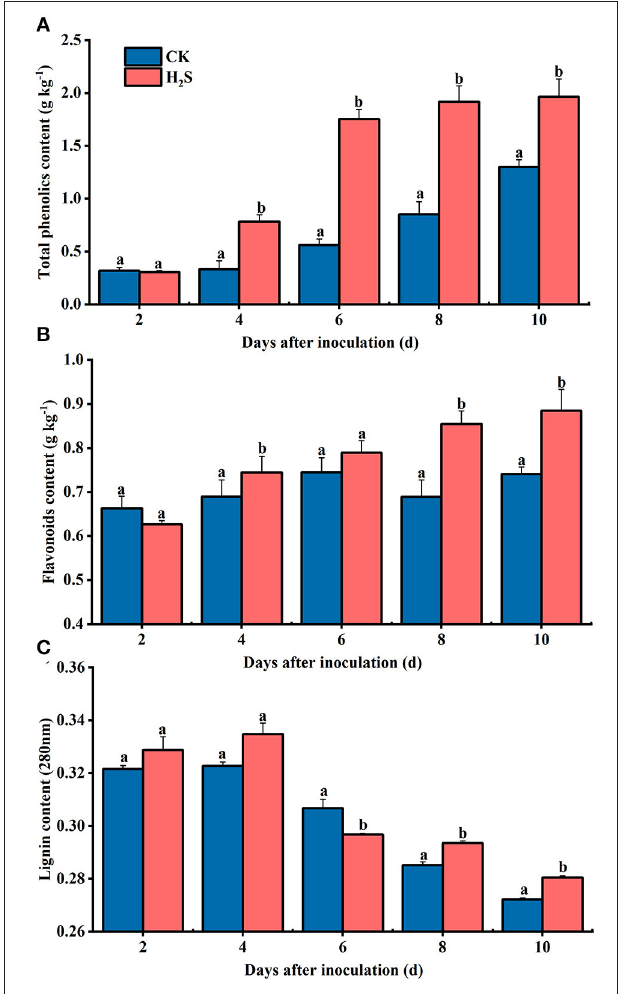
FIGURE 6 | Contents of total phenolic (A) , flavonoids (B) , and lignin (C) in kiwifruit with inoculation of B. dothidea after H 2 S treatment during storage at 25 ◦ C. Vertical bars represent the standard errors. Letters indicate significant differences ( P <